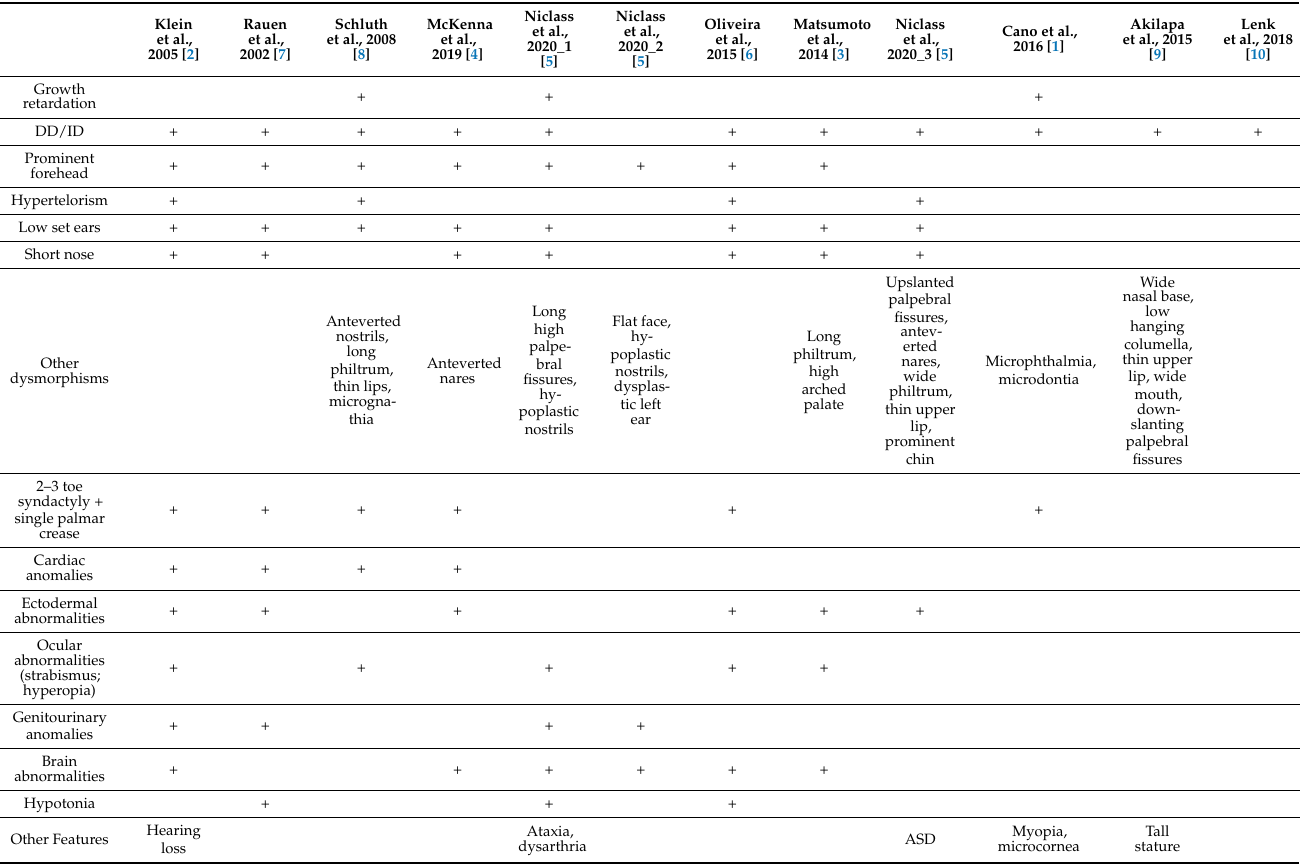
Table 2. Clinical data of 12q21 deleted patients described in the literature.